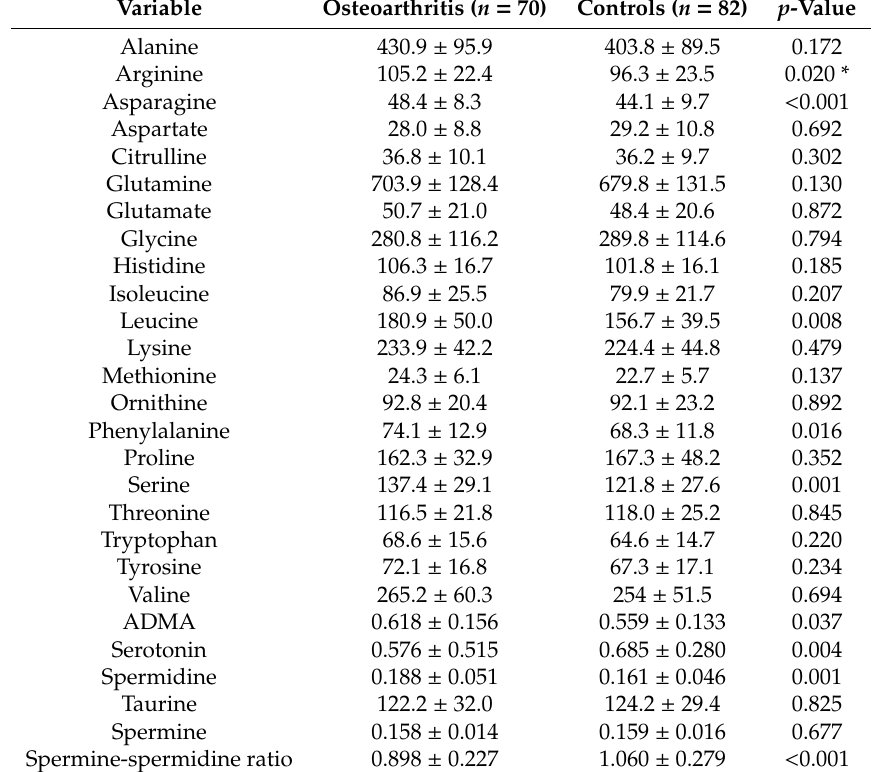
Table 2. Amino acid and biogenic amine levels of osteoarthritis and the control